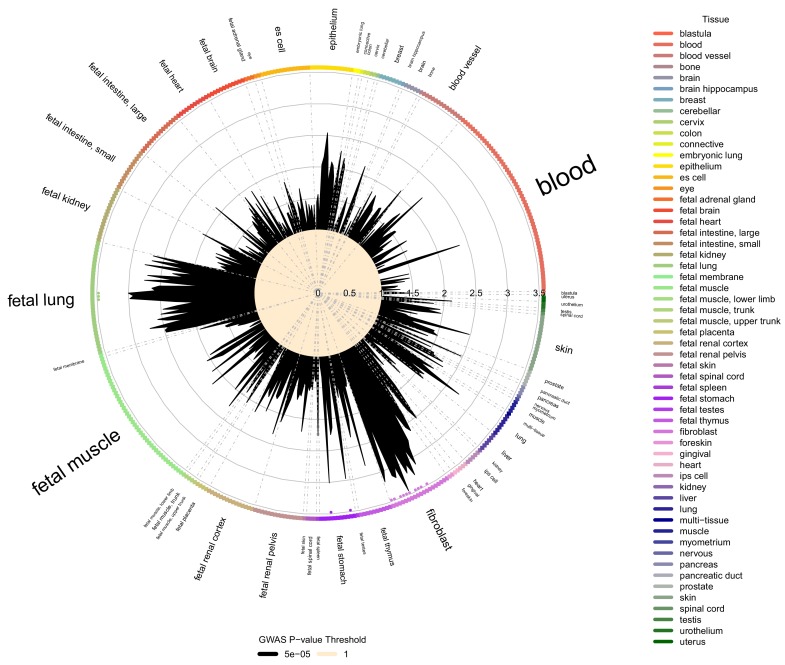
Cell type and tissue enrichment for moderate centribloular emphysema GWAS signals.Using Garfield (Iotchkova et al., 2019) for enrichment analysis, we tested the enrichment of moderate centrilobular GWAS loci (harboring associations a p<5×10−5) in DNaseI peaks from 424 cell lines and cell types in ENCODE and Roadmap. Significant enrichments were observed in fetal lung, fetal stomach, and multiple fibroblast cell types. These significant enrichments are denoted by colored dots located just inside the boundary of the circle of cell types.